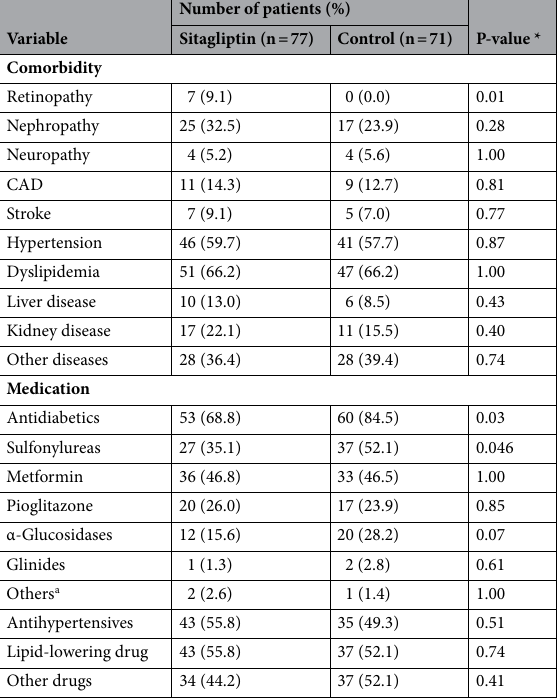
Table 2. Comorbidity and medication at baseline. *Between-group differences based on Fisher’s exact test. CAD coronary artery disease. a Epalrestat prescribed for diabetic neuropathy (n = 1 in sitagliptin group and n = 1 in control group) and imidapril for diabetic nephropathy (n = 1 in sitagliptin group) are listed as others (other antidiabetic